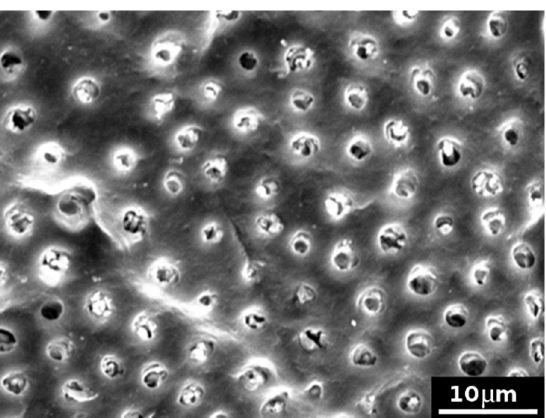
Figure 6. SEM picture ( × 2000) of a model dentine surface treated with the formulation 1 and subsequently exposed to citric acid attack: model dentinal tubules appeared almost completely closed. Some tubules have been slightly opened by the acid attack, whereas many clasts are observed.